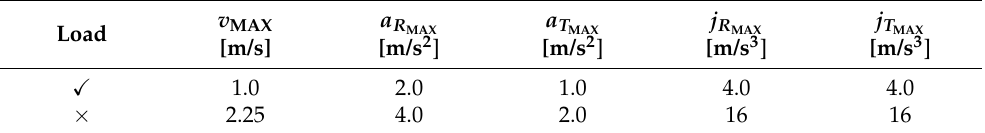
Table 2. Constraints on velocity, acceleration, and jerk for a fully loaded ( (cid:88) ) and an unloaded (×) mobile